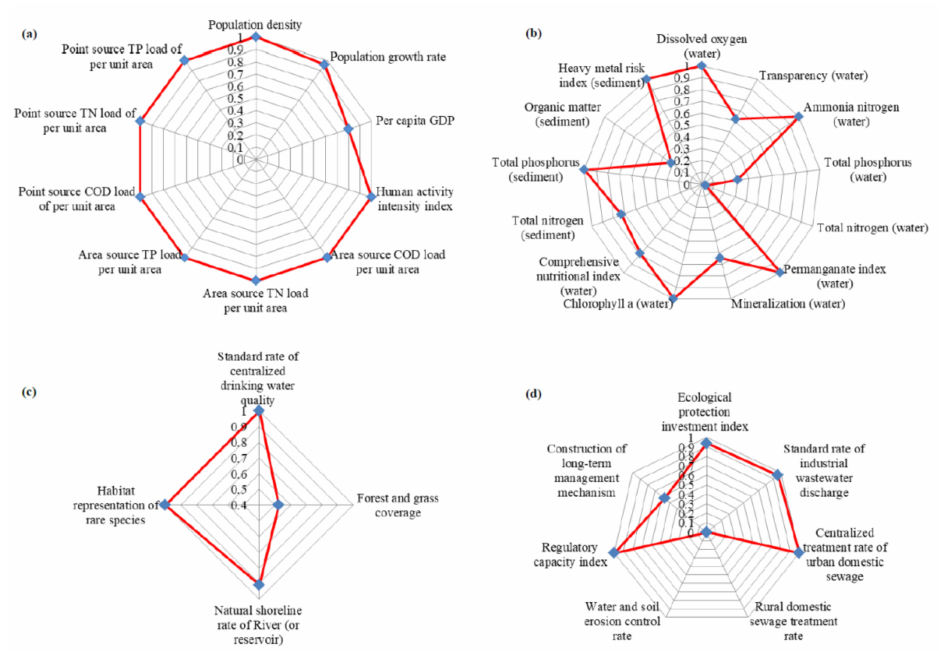
Figure 6. Radar diagrams for the four factors in the SEEC model: ( a ) socioeconomic impact assessment results, ( b ) ecological health assessment results, ( c ) ecological services function assessment results, and ( d ) control management assessment